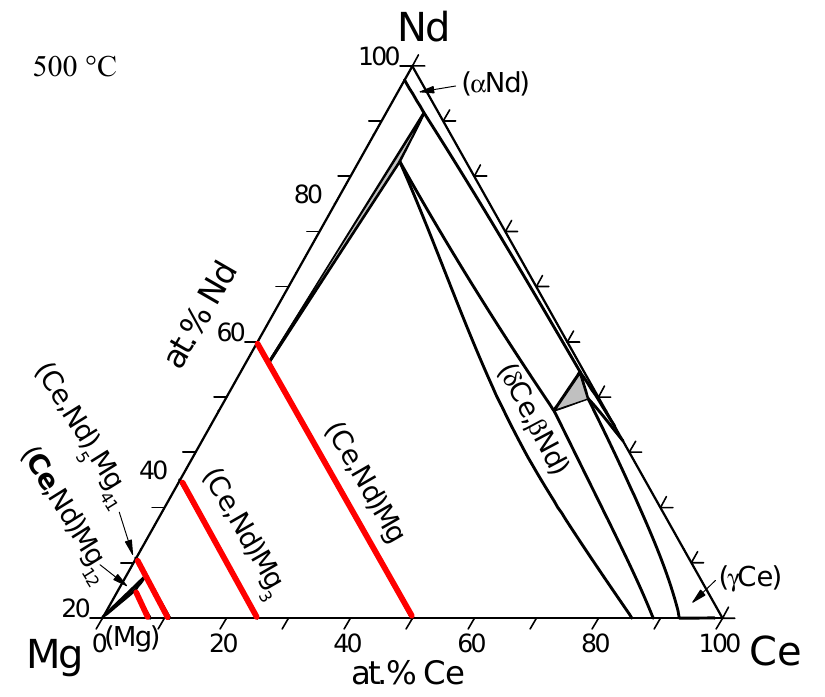
Figure 4. Calculated isothermal Mg-Ce-Nd phase diagram at 500 °C highlighting intermetallic phases with continuous (3) or limited (1) ternary solubility [36].